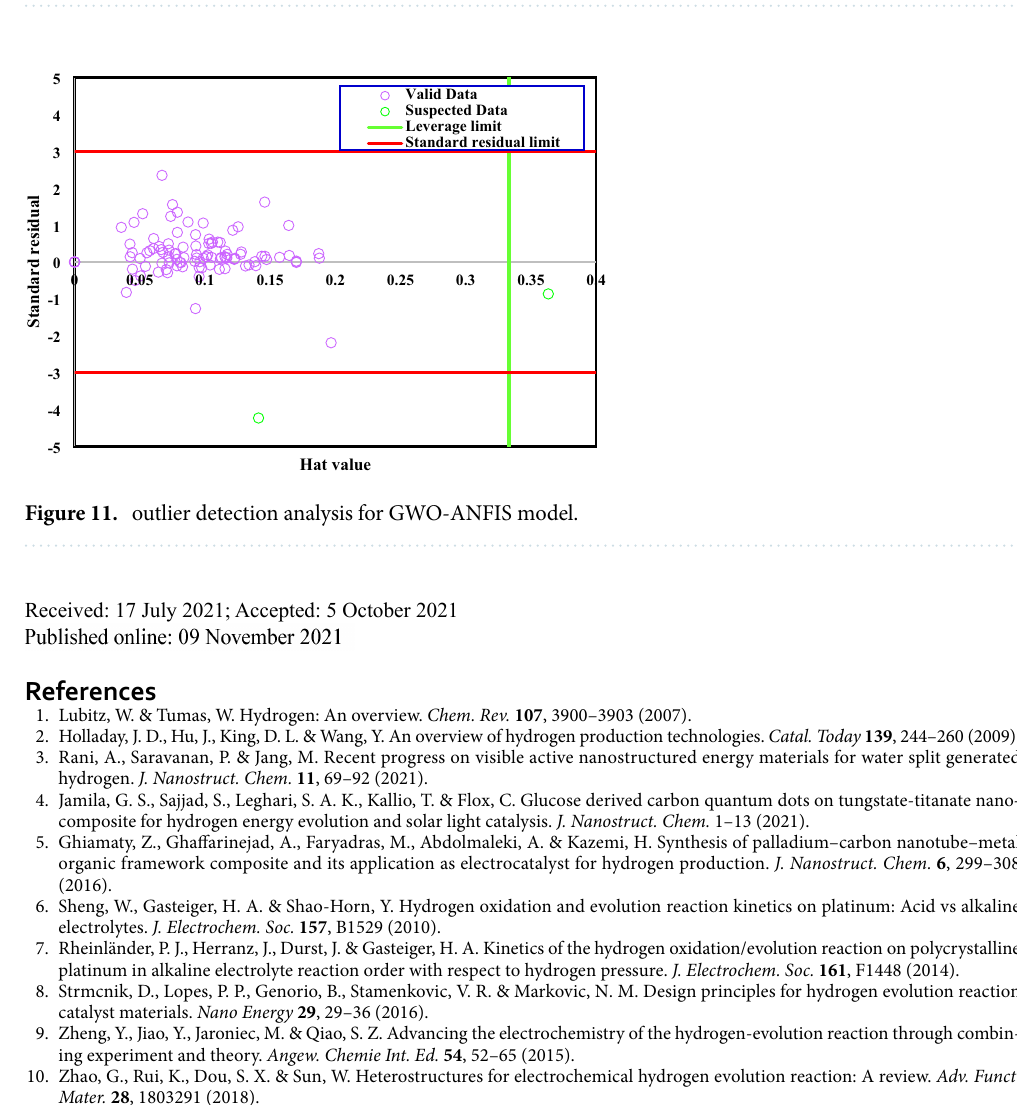
Figure 10. Relative deviation percentage of GWO-ANFIS model.